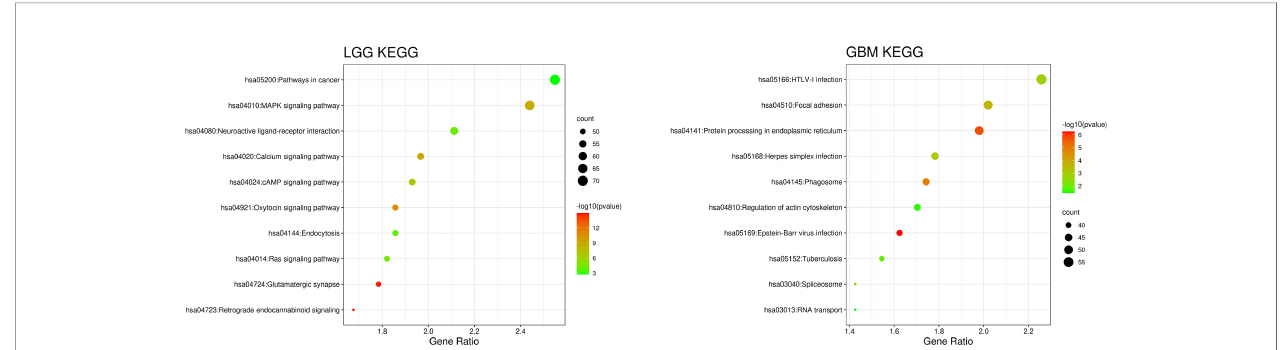
FIGURE 4 | Patient gene expression analysis was performed using the Kyoto Encyclopedia of Genes and Genomes (KEGG) database provided by the DAVID website for correlation analysis. The orders of the biological processes listed in the bubble chart are based on the number of targets annotated in biological process